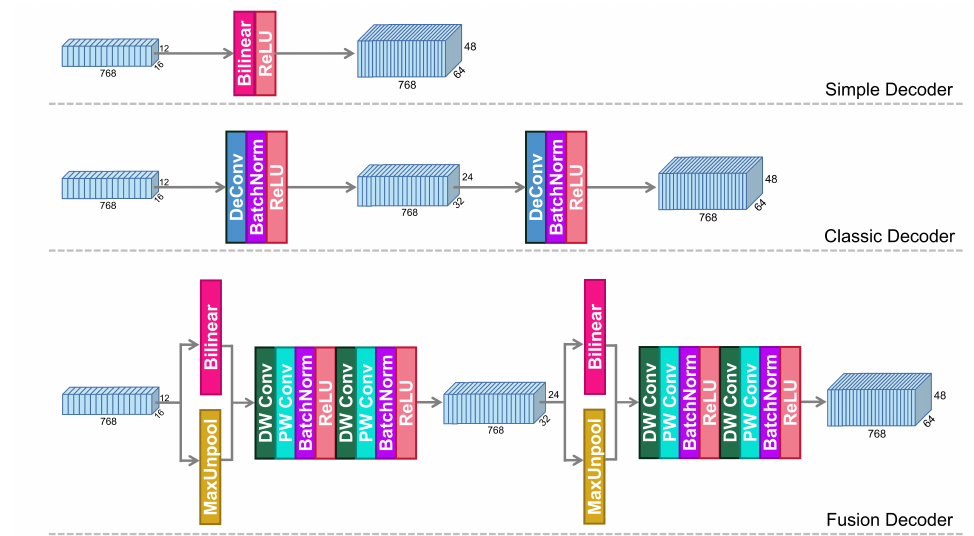
Figure 4. Comparison among different decoders including the Fusion Decoder (our), Classic Decoder (ViTPose), and Simple Decoder